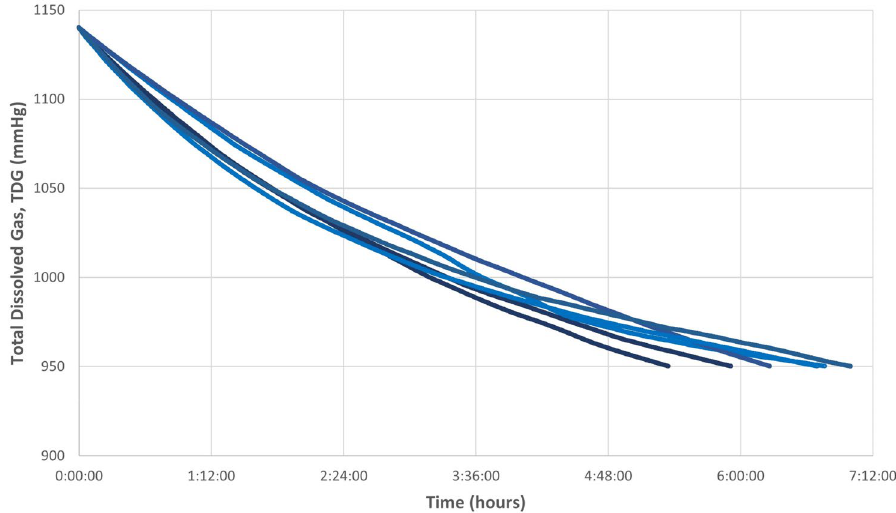
Figure 1. Graphical representation of the evolution of supersaturated water in an open aquarium without recirculation based on experiments performed from 1140 mmHg (150% of TDG). Each line corresponds to six different experiments with a similar pattern of TDG decrease in all of